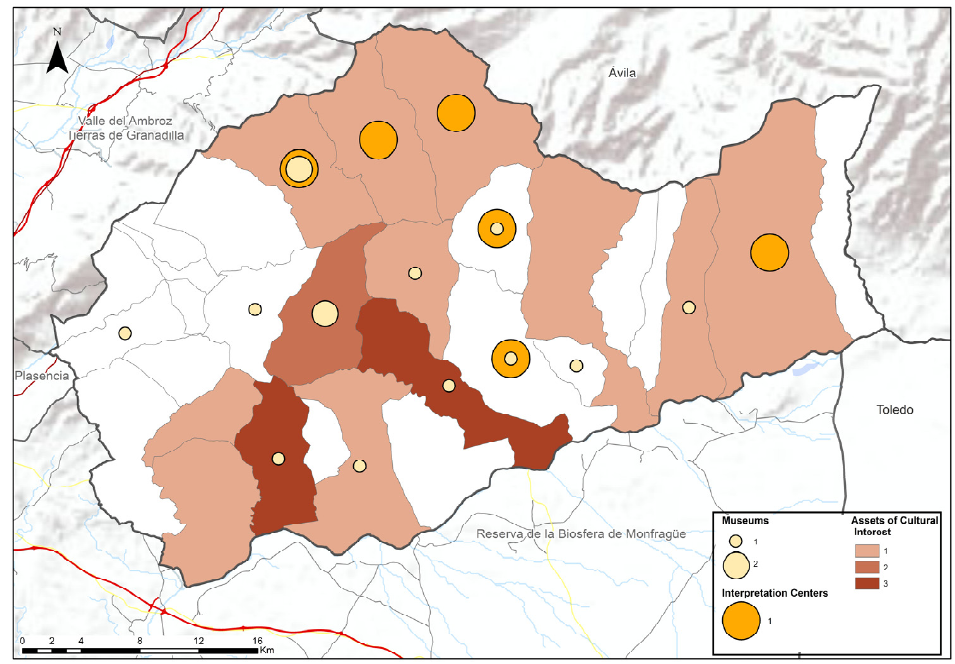
Figure 6. Map of the assets of cultural interest, museums and interpretation centers.